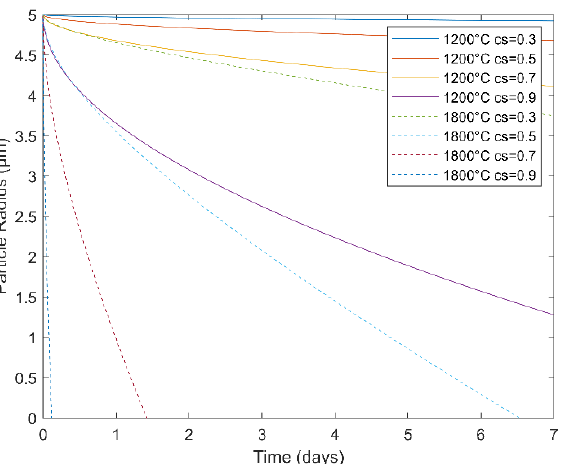
Figure 1. Dissolution kinetics model of spherical W inclusions in a Nb matrix during heat treatment of